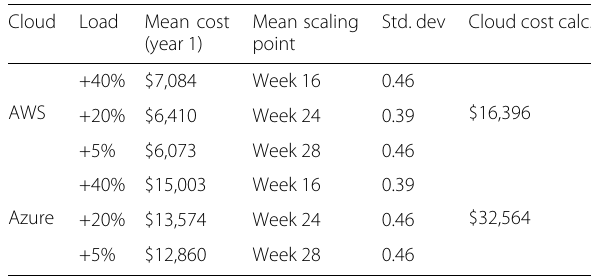
Table 6 Predicted cloud running costs for Apache OFBiz